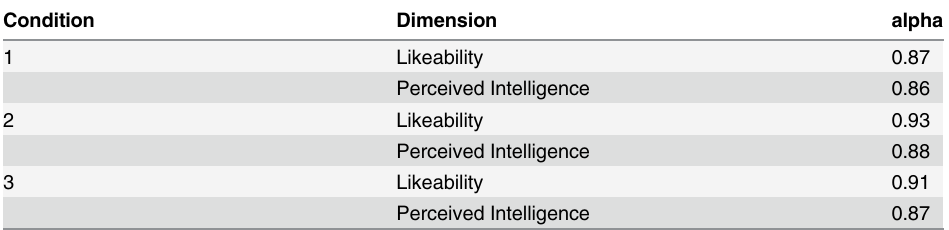
Table 2. Godspeed questionnaire reliability.